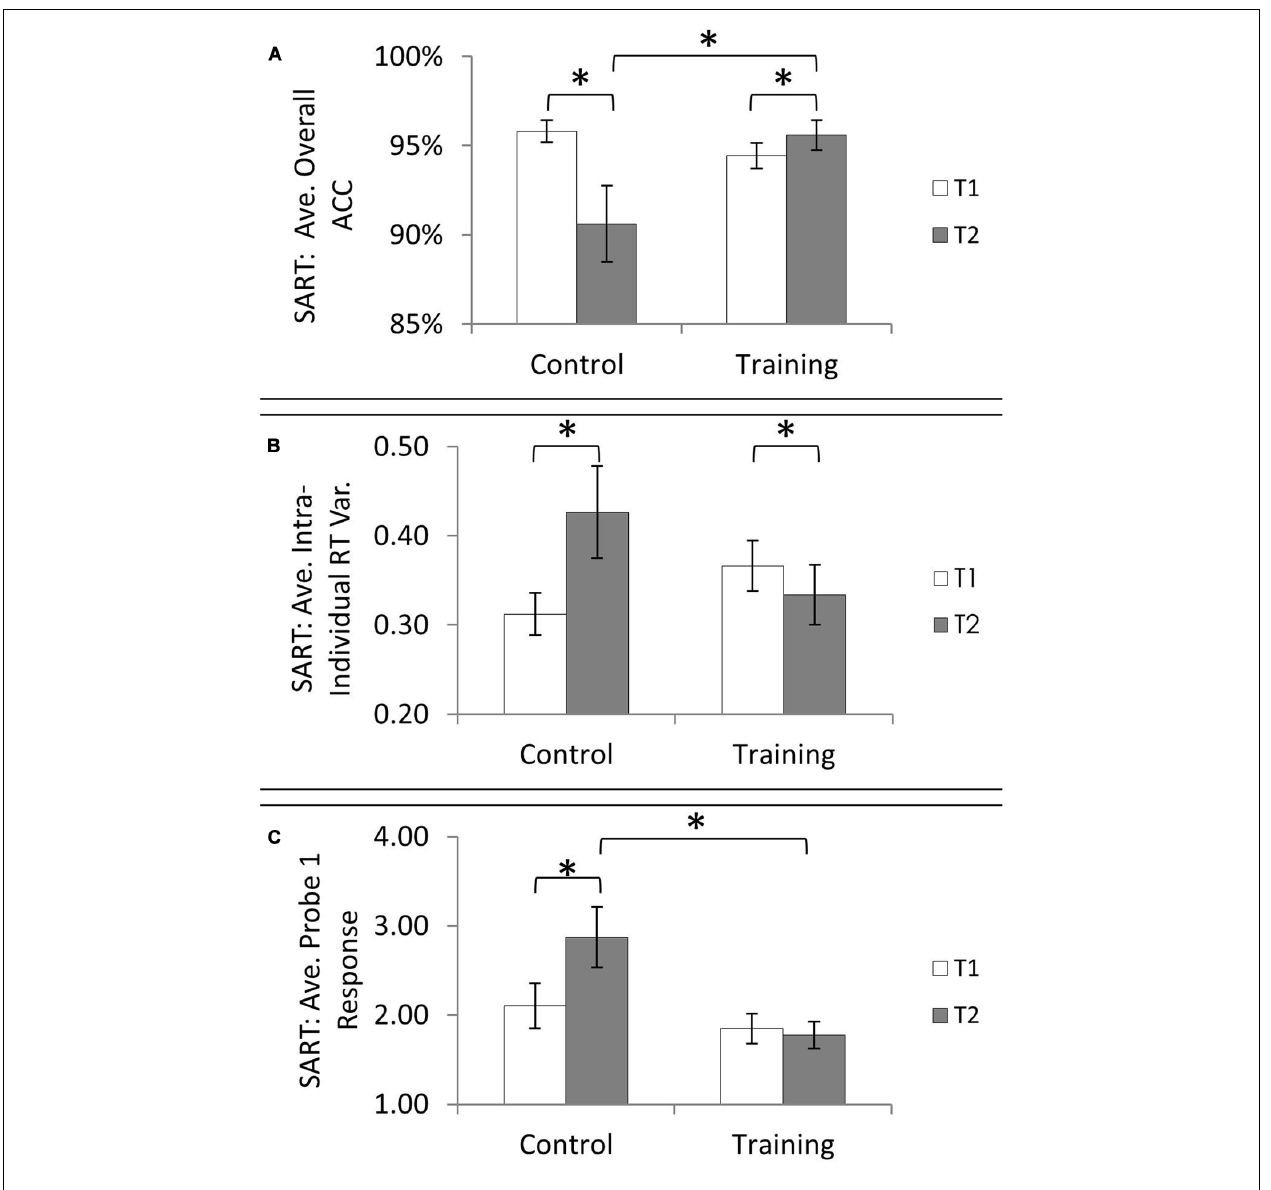
Probe 1 which asked, “Where was your attention focused just before the probe?” A numerically higher probe response suggests more “off-task” thinking. Asterisks denote that paired comparisons revealed significance at alpha of